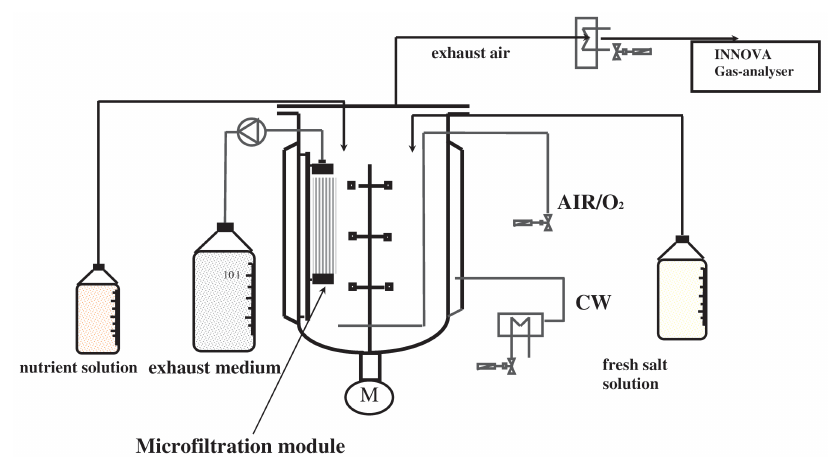
Figure 1. Schematic view of the microfiltration bioreactor (adapted from Schiraldi et al.